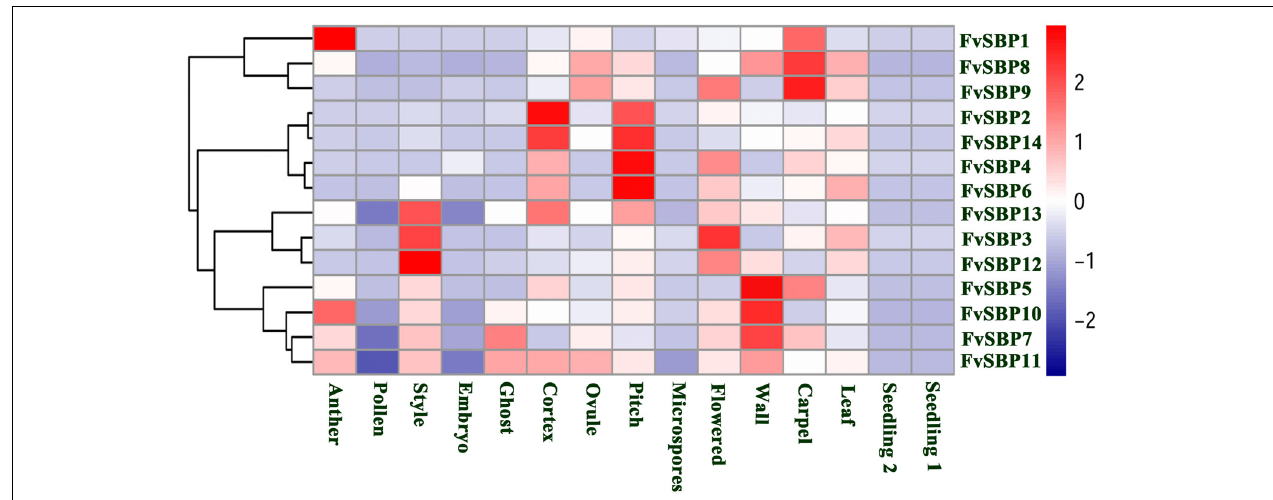
FIGURE 8 | Expression profiling of Strawberry FvSBP-box genes fifteen samples from seedling, root, leaves, and flowering in different development stages. Blue and red colors indicate low-expression and high-expression,